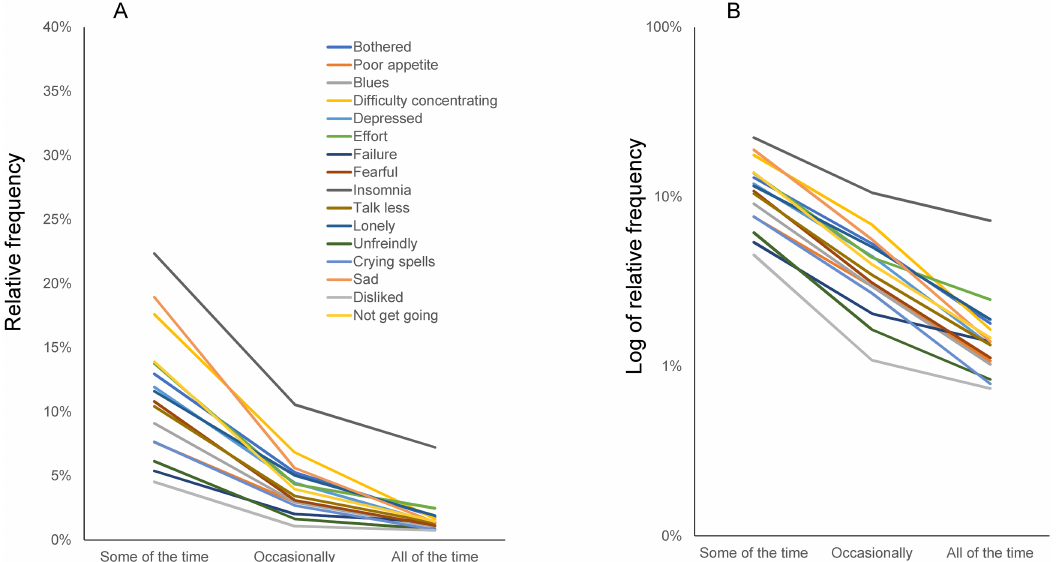
Fig 4. Item responses to the 16 depressive symptom items from “some of the time” to “all of the time.” Responses to the 16 items from “some of the time” to “all of the time” along a normal scale (A) and a log-normal scale (B). (A) Lines for the 16 items converged from “some of the time” to “all of the time.” (B) Most of the item responses for the 16 items follow a parallel pattern between “some of the time” and “all of the time.” The lines for “insomnia,” “failure,” and “dislike” were not in such a parallel pattern as that seen for the other